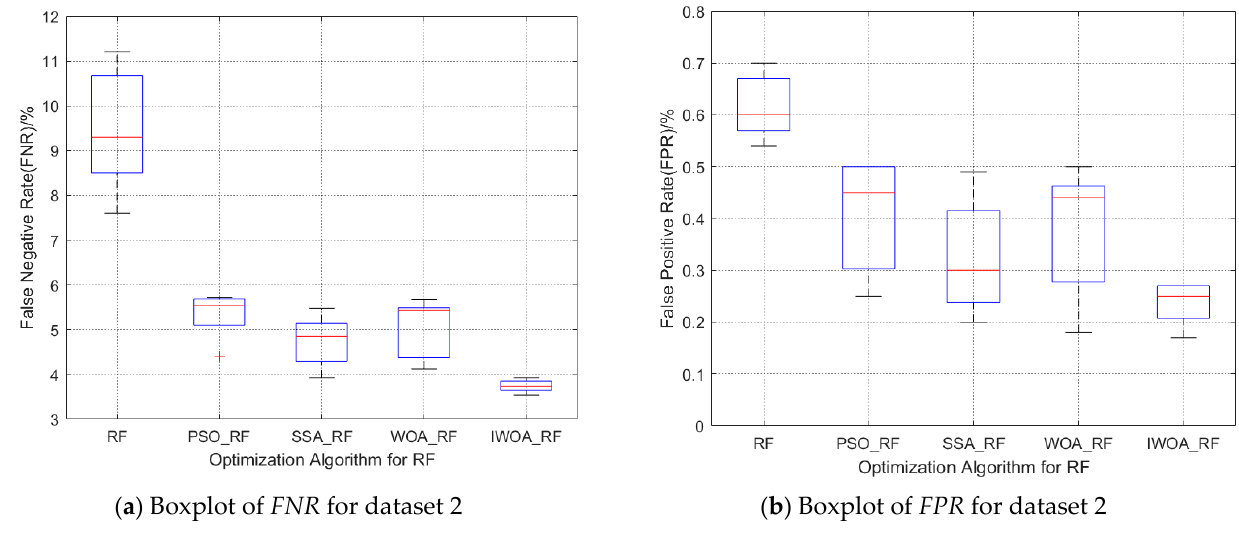
Figure 6. Boxplot of FNR and FPR for dataset 2.